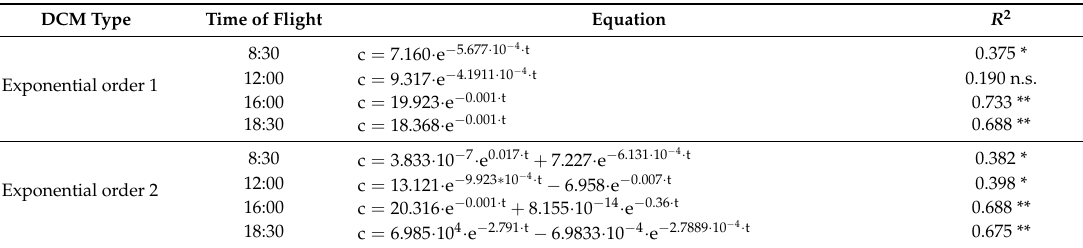
Figure 4. Relationship obtained between the variation of digital number per second ( ∆ DN/sec) and flight duration for exponential, exponential order 2, lineal, quadratic, bicubic, and quartic drift correction models at ( a ) 8:30 a.m., ( b ) 12:30 p.m., ( c ) 16:00 p.m., and ( d ) 18:00 p.m. Table 2. Drift correction models for each mission and coefficient of correlation (R 2